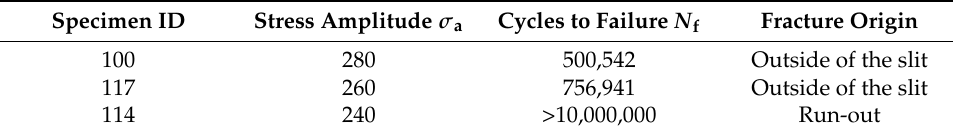
Table A5. Fatigue test results for WNS1.0.